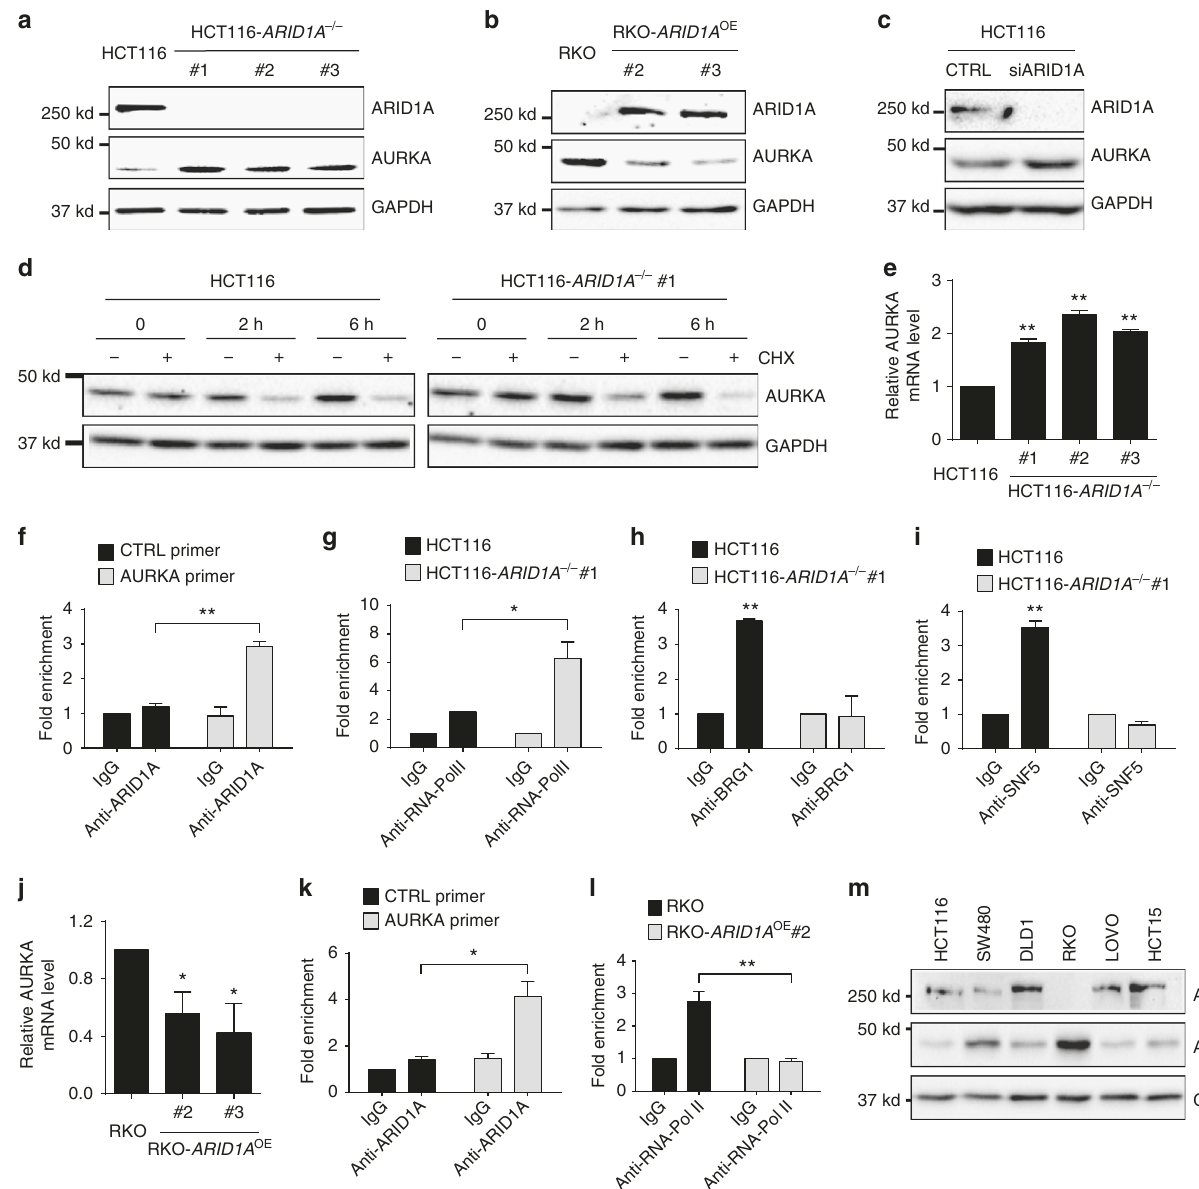
Fig. 5 AURKA is a target gene for transcription repression by ARID1A. a Upregulation of AURKA level in ARID1A − / − HCT116 cells. b Downregulation of AURKA level in ARID1A overexpressing (ARID1A OE ) RKO clones. c Upregulation of AURKA level in HCT116 cells by ARID1A silencing. d Measurement of AURKA protein half-life in ARID1A isogenic HCT116 cells. Cells were treated with or without 10 μ M cycloheximide (CHX) for the indicated time points and pre-existing AURKA protein stability was analyzed. e RT-qPCR analysis of AURKA mRNA level in HCT116 ARID1A + / + and ARID1A − / − clones. ** P < 0.01 vs HCT116 ( ARID1A + / + ), one-sample t test. f Chromatin immunoprecipitation (ChIP) of AURKA promoter in ARID1A + / + HCT116 cells using anti-ARID1A antibody. ChIP data were normalized to the control IgG ChIP with the control (CTRL) primer. ** P < 0.01, Student ’ s t test. g ChIP of AURKA promoter in HCT116 ARID1A + / + (black) and ARID1A − / − (gray) cells using anti-RNA-Pol II antibody. IgG in each cell line was used as a normalization control. * P < 0.05, Student ’ s t test. h ChIP of AURKA promoter in HCT116 ARID1A + / + (black) and ARID1A − / − (gray) using anti-BRG1 antibody. IgG in each cell line was